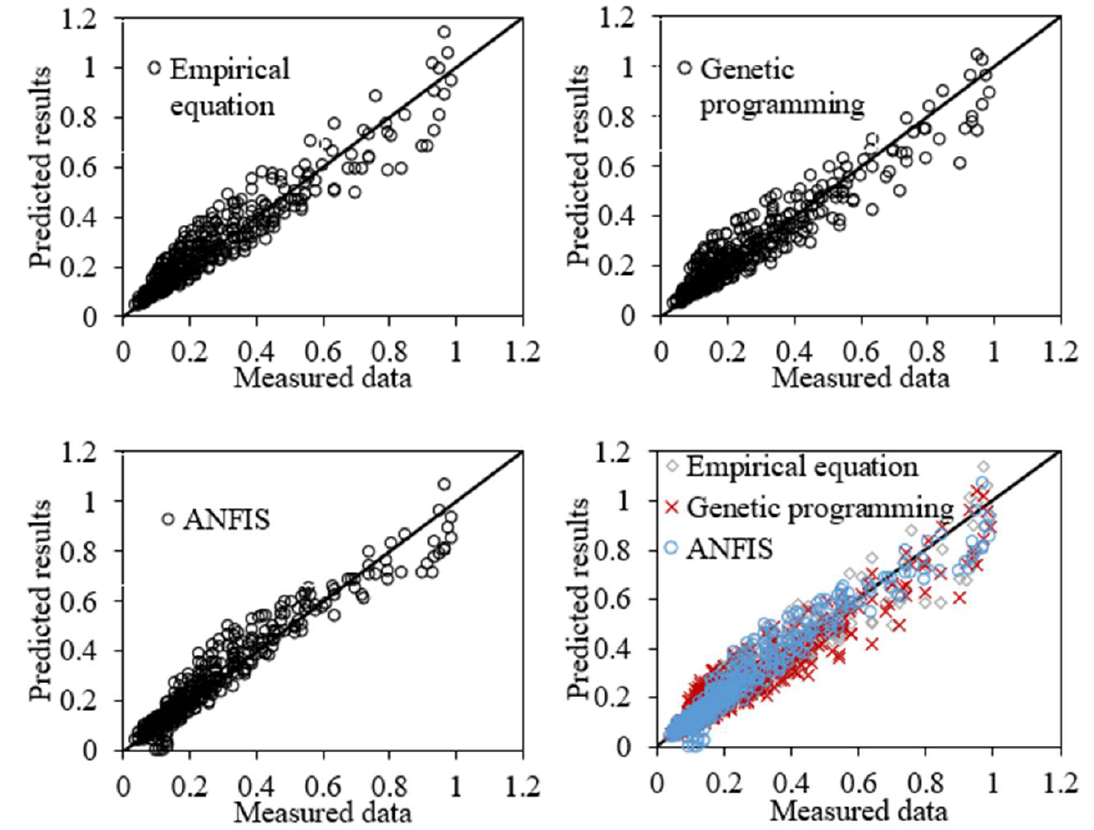
Table 2. Performance indices for the predictions obtained by three different methods: empirical equations, genetic programming, and the ANFIS model.